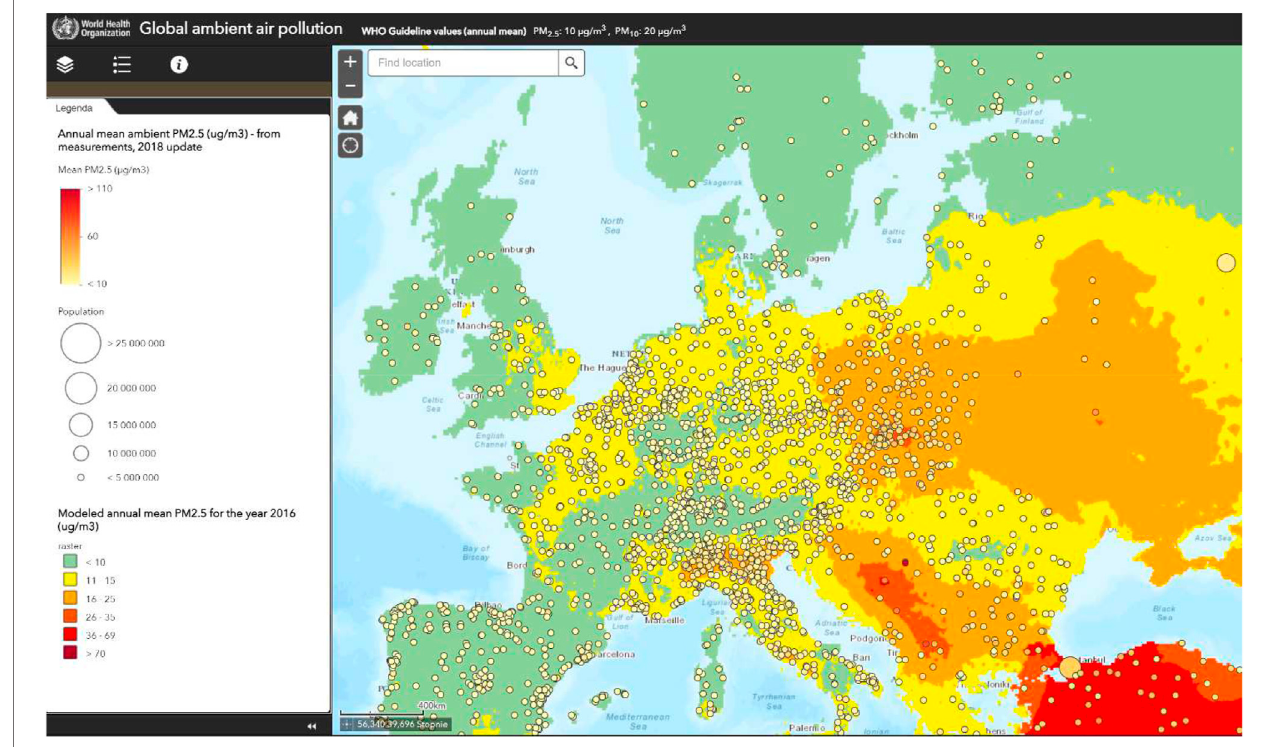
FIGURE 1 | WHO: Global ambient air pollution. Update